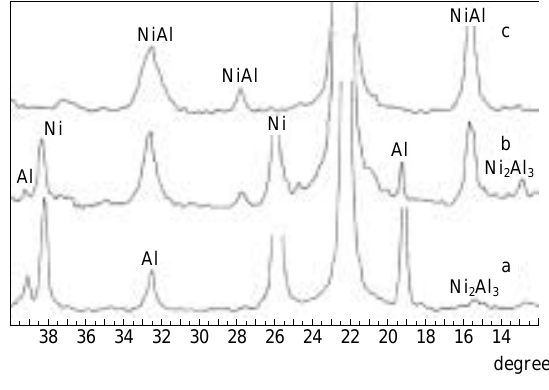
X-ray patterns of Ni 32 wt.% Al mixture after mechanical activation during 3 (a), 7 (b), 25 min.